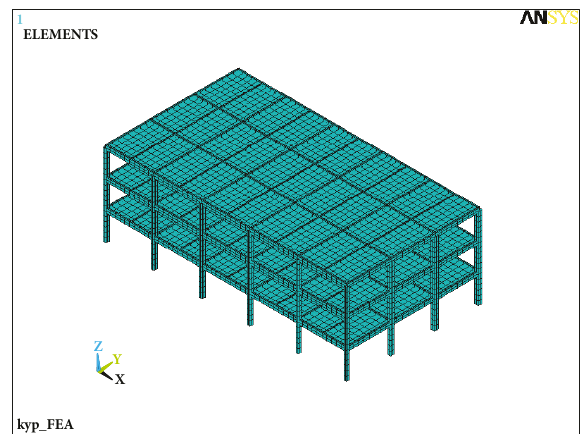
Figure 20: The 3D refined model corresponding to the simplified